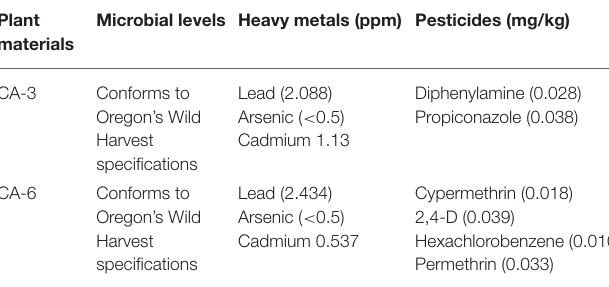
TABLE 2 | Contaminant content of bulk CA samples selected for mass